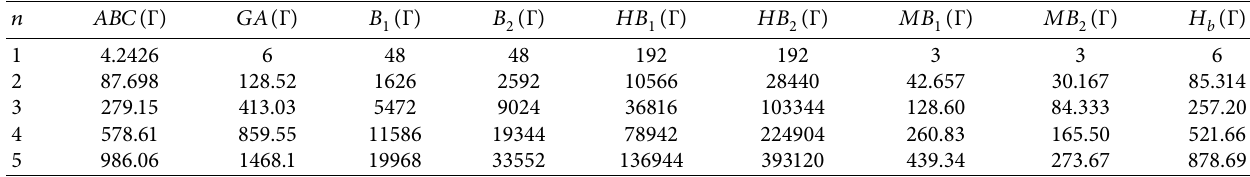
Table 3: Numerical comparison for Theorem 3.